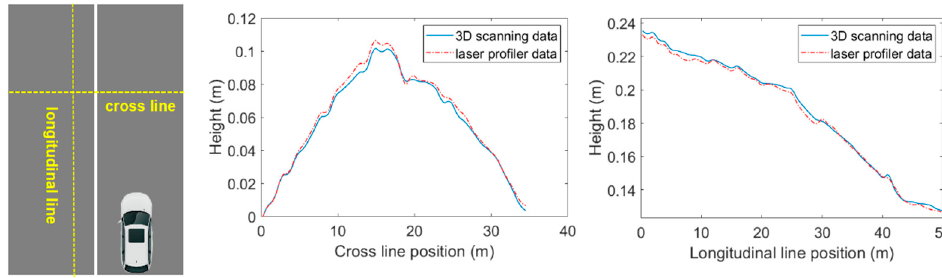
Figure 6. Raw 3D data and filtered 3D data of Case 1(a,b) and Case 2 (a,b).